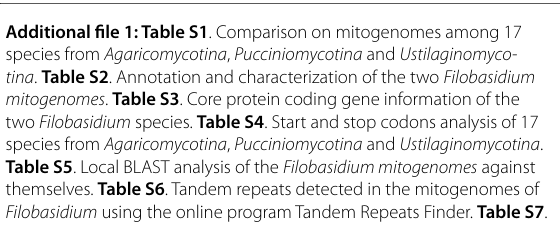
Table S5 . Local BLAST analysis of the Filobasidium mitogenomes against themselves. Table S6 . Tandem repeats detected in the mitogenomes of Filobasidium using the online program Tandem Repeats Finder. Table S7